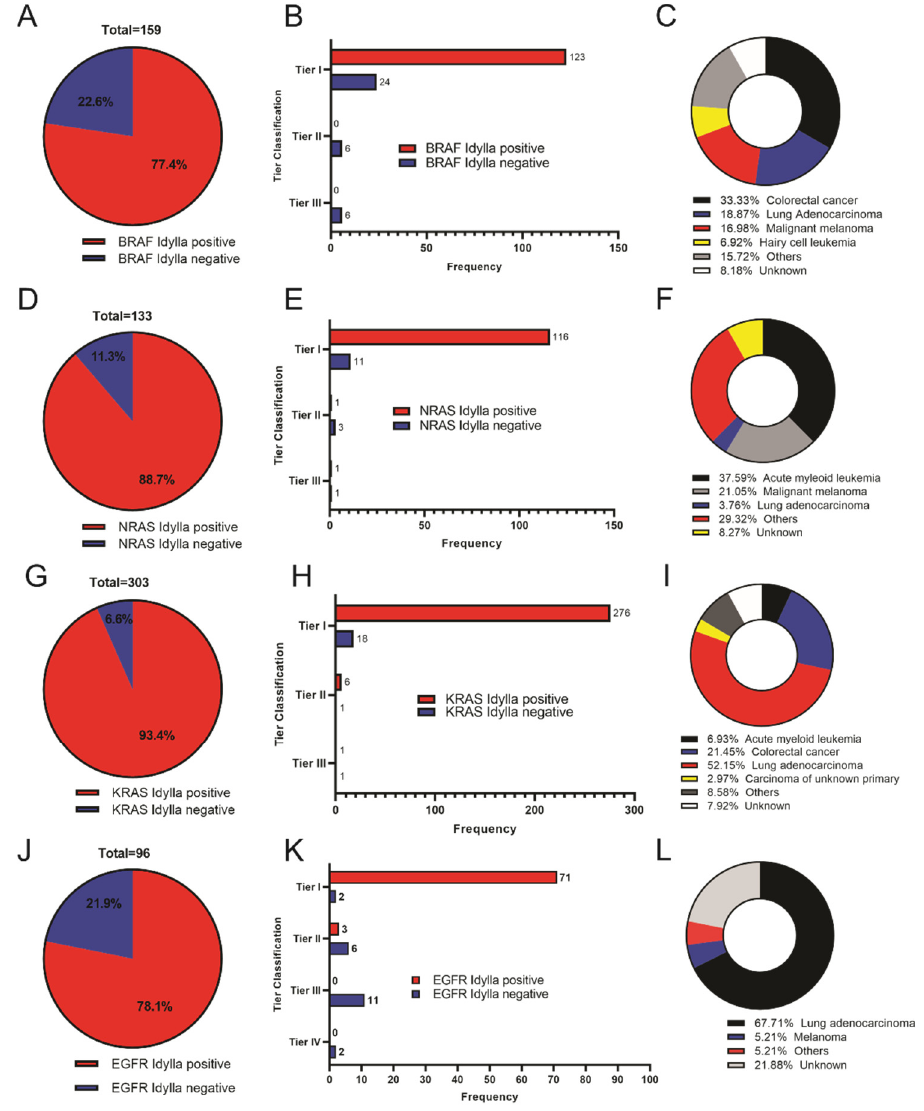
Figure 1. Proportion of gene mutations identified on NGS that would be positive on Idylla molecular testing. ( A – C ) Percentage of BRAF mutations identified on NGS panel that would be detected on Idylla system and associated Tier classification and primary site diagnosis. ( D – F ) Percentage of NRAS mutations identified on NGS panel that would be detected on Idylla system and associated Tier classification and primary site diagnosis. ( G – I ) Percentage of KRAS mutations identified on NGS panel that would be detected on Idylla system and associated Tier classification and primary site diagnosis. ( J – L ) Percentage of EGFR mutations identified on NGS panel that would be detected on Idylla system and associated Tier classification and primary site diagnosis.